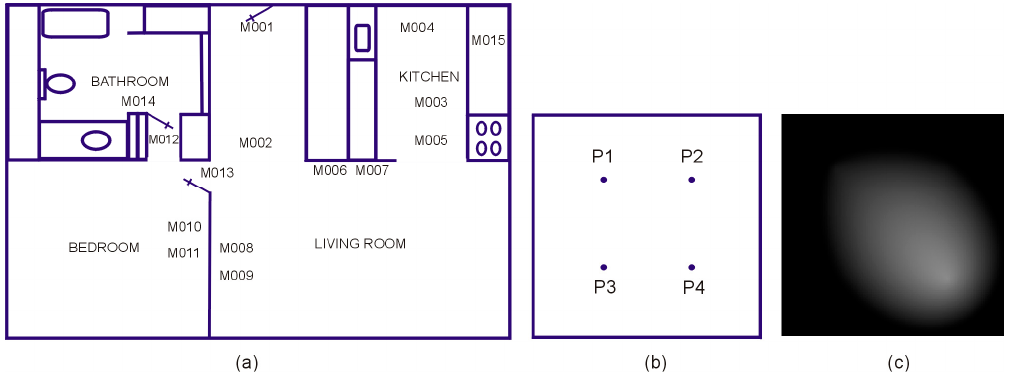
Figure 5. ( a ) Floor plan and sensor layout for CASAS HH126 testbed, ( b ) the corresponding generic space, and ( c ) a sample pheromone map describing the activity within this space.